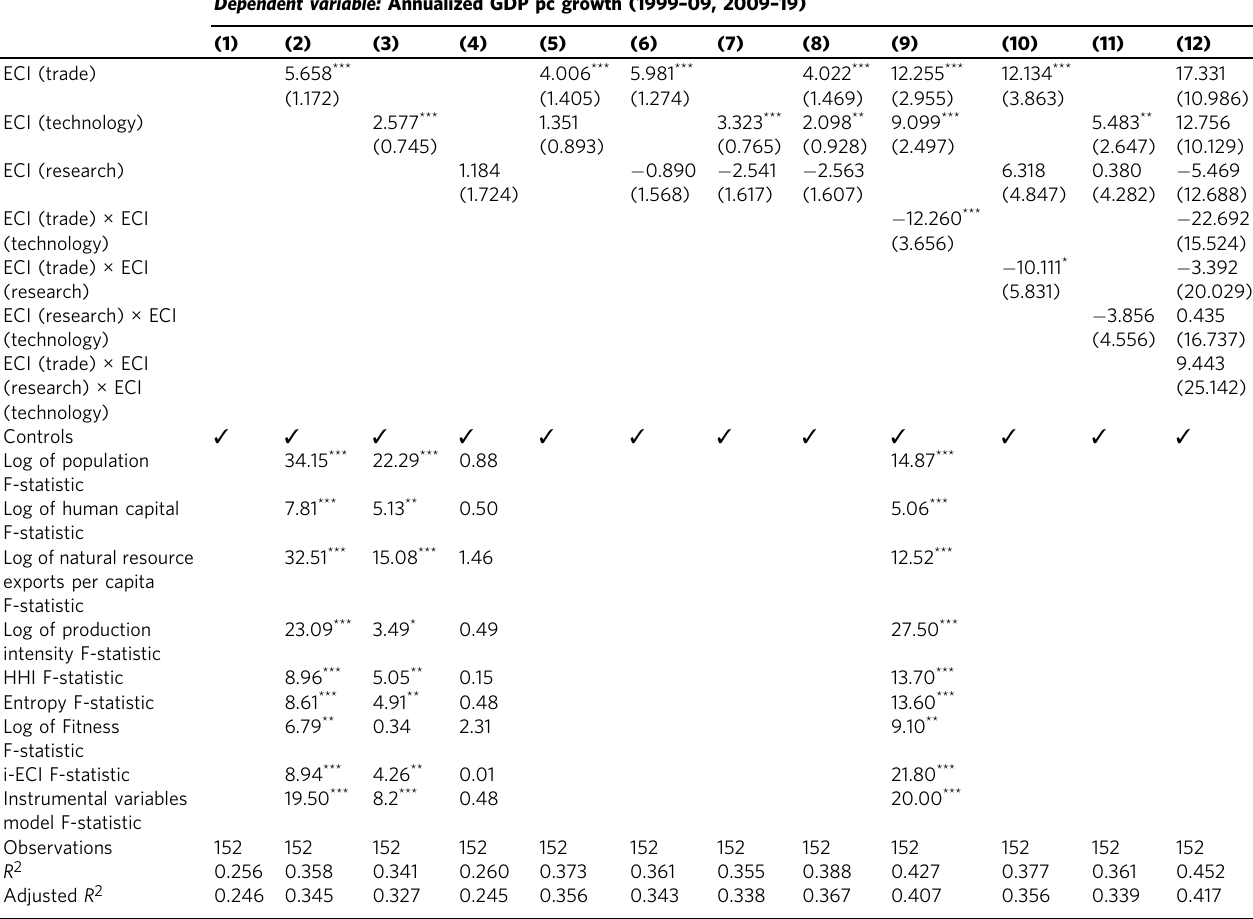
Table 1 Multidimensional complexity and economic